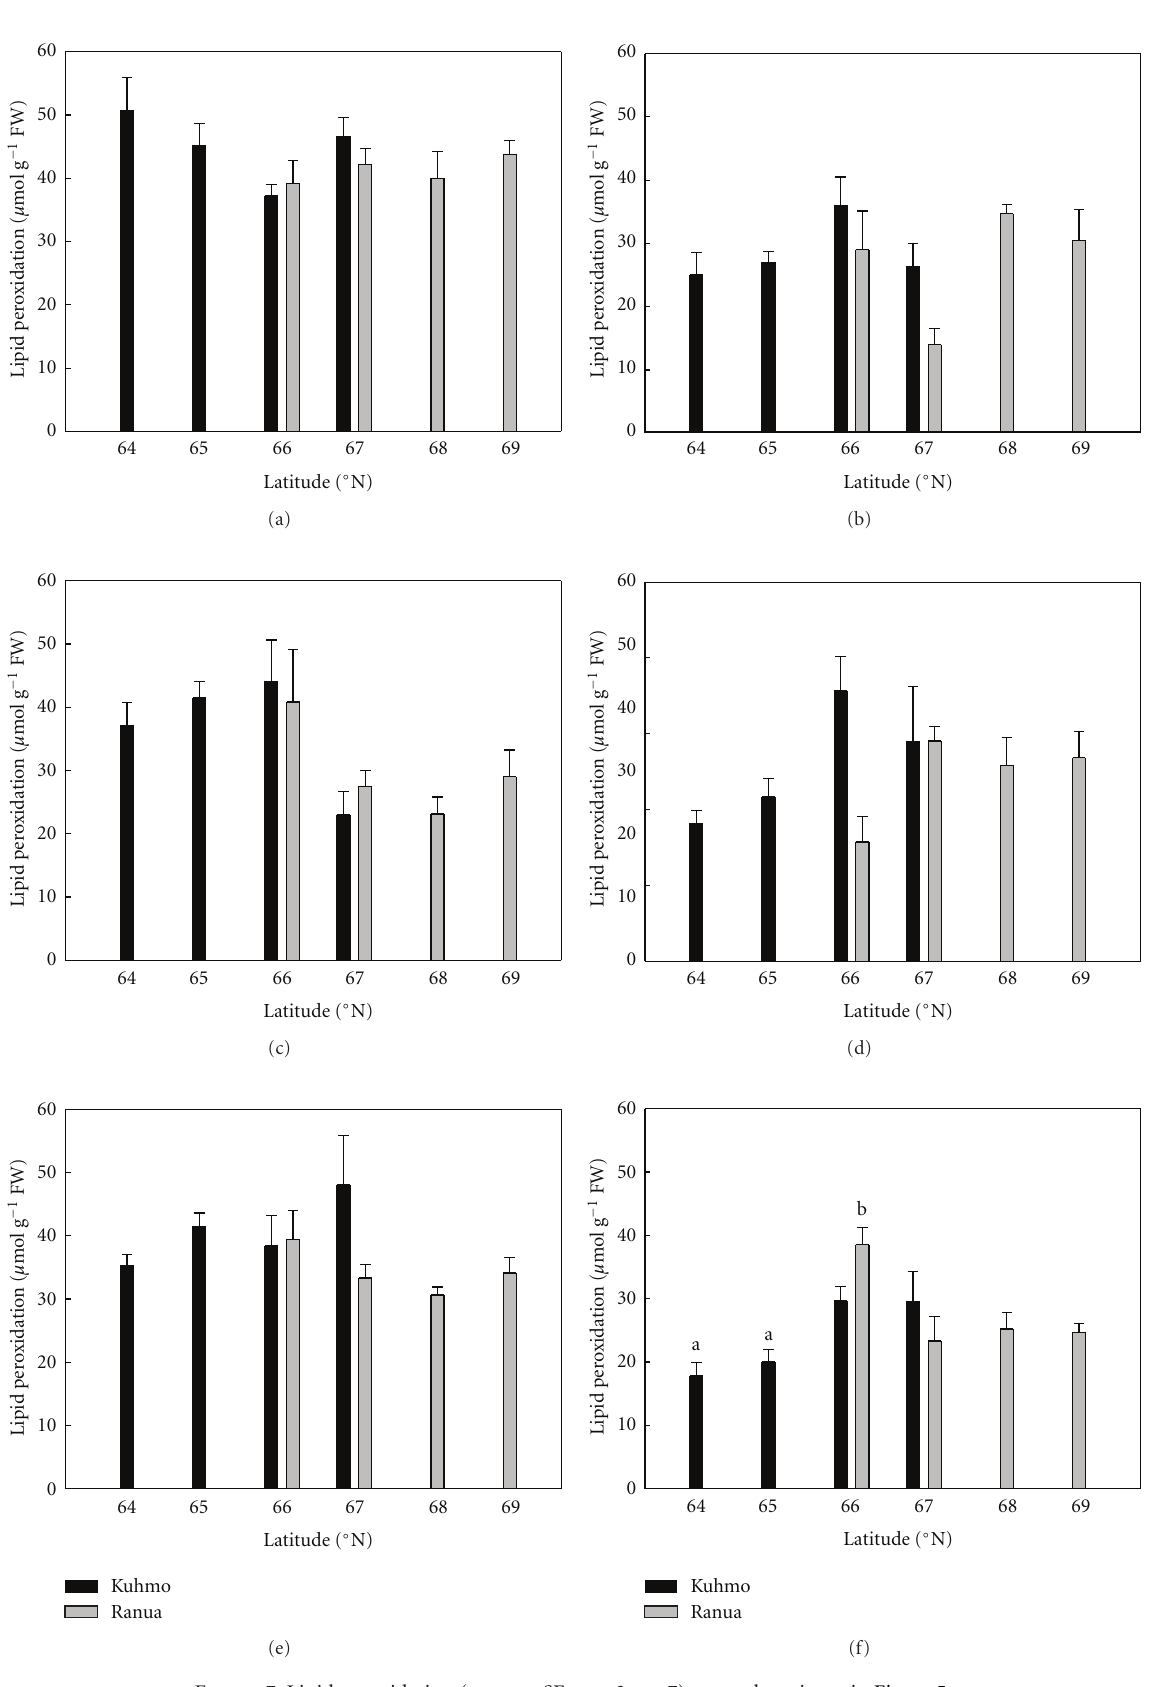
Figure 7: Lipid peroxidation (mean ± SE, n = 3 − − 7), text otherwise as in Figure